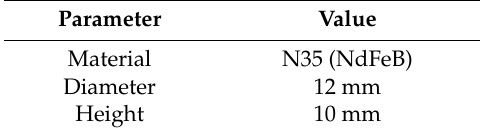
Figure 4. The configuration of the ECTMD.